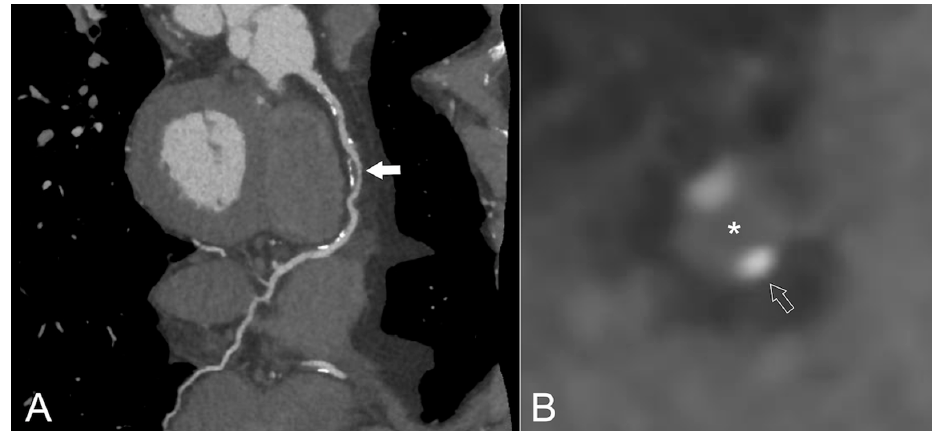
Figure 3. Non-invasive evaluation of an asymptomatic 65-year old HIV+ male patient. The patient had a history of treated arterial hypertension, was an active smoker and suffered from peripheral artery disease with the latter prompting further cardiovascular work-up despite a normal stress-electrocardiogram. Multiplanar curved reconstruction of the coronary computed tomography angiography dataset ( A ) reveals multiple calcified but non-obstructive lesions and 70–90% stenosis (white filled arrow) in the mid-right coronary artery. This obstructive lesion ( B , cross sectional view) exhibits several morphological high-risk features typical for an event-prone lesion, such as positive remodeling and a low-attenuation core (*) with calcifications only at the edge of the lesion (white empty arrow), constituting the so-called napkin-ring sign.